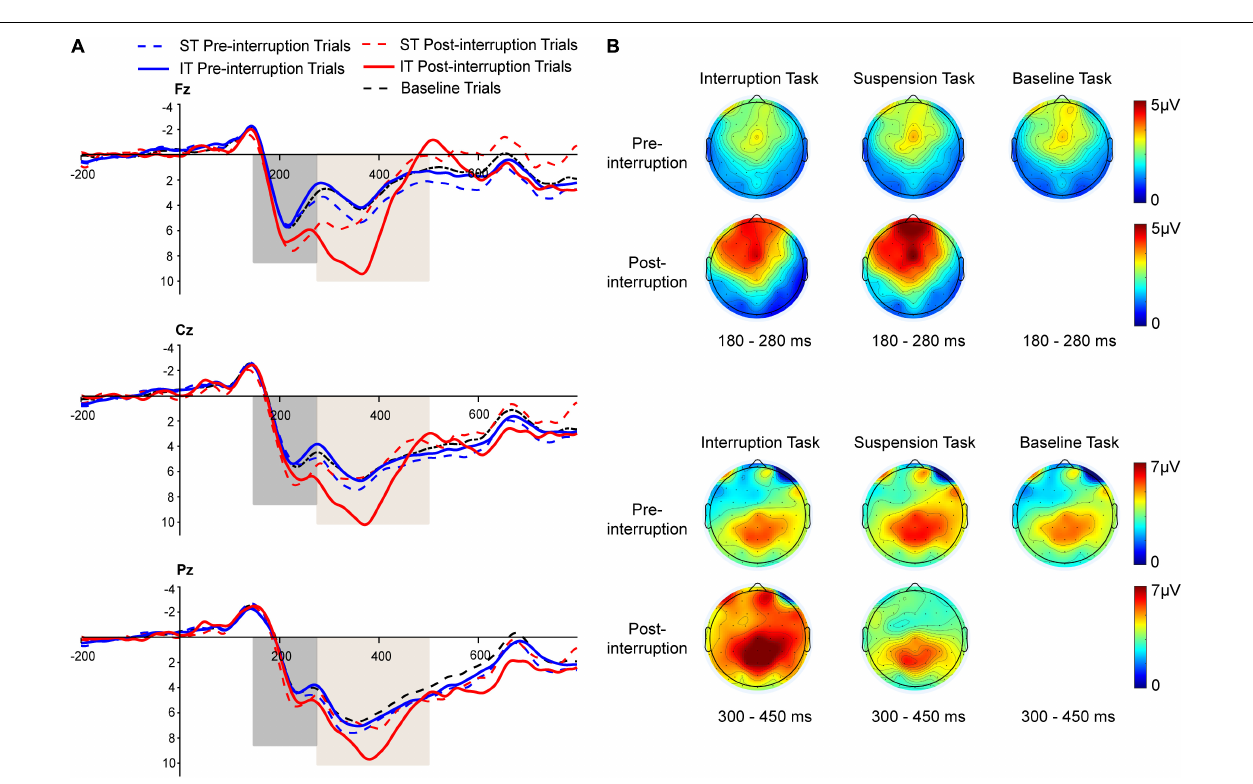
FIGURE 5 | (A) Grand averages of P200 and P300 event-related potentials (ERP) components at the Fz, Cz, and Pz electrodes under non-fatigue state. The black dashed line represents all trials of the baseline task. The blue and red dashed lines represent the pre- and post-interruption trials of the suspension task (ST). The blue and red solid lines represent the pre- and post-interruption trials of the interruption task (IT). (B) The scalp topographies display the mean amplitude under non-fatigue state of 180–280 ms for P200 and 300–450 ms for